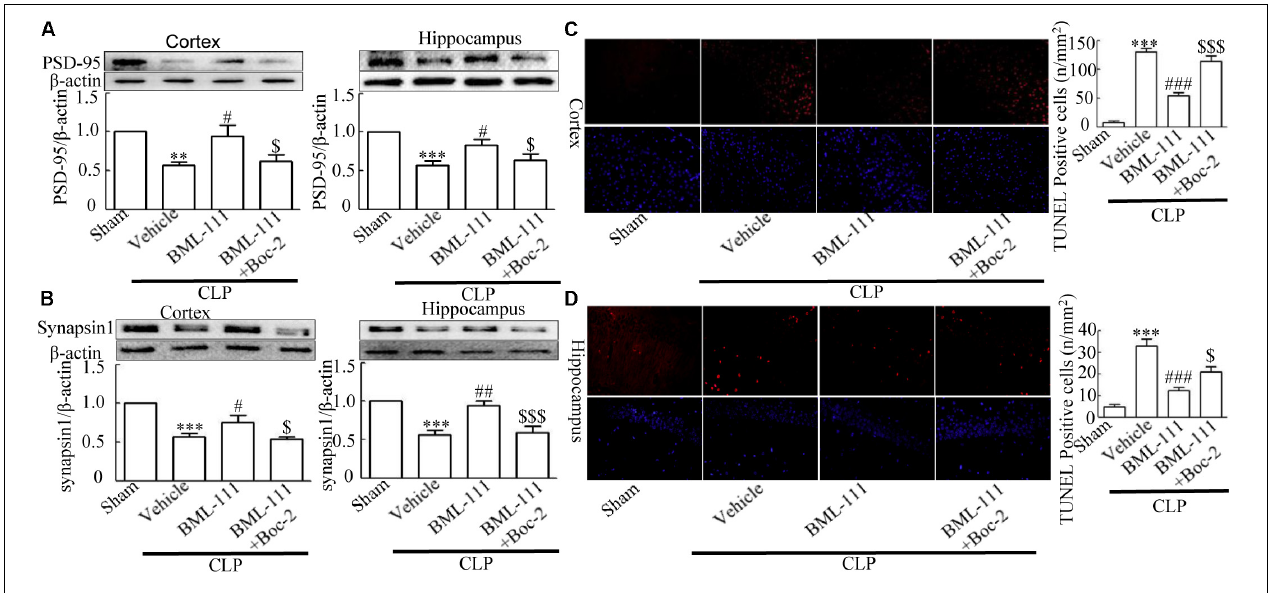
FIGURE 4 | BML-111 treatment reduces the decreases in PSD95, Synapsin1 and TUNEL-positive cells. PSD95 and Synapsin1 (A,B) in the cortex and hippocampus were significantly reduced in CLP mice compared with the sham group. BML-111 treatment increased the expression of PSD95 and Synapsin1 in CLP mice, and Boc-2 decreased the effects of BML-111. (C,D) The number of TUNEL-positive cells was significantly increased in CLP mice compared with the sham group. BML-111 treatment reversed this variation in CLP mice, and Boc-2 reduced these effects. Scale bars indicate 20 mm. Data were shown as the means ± SEM ( n = 6 surviving mice in A cortex, n = 5 surviving mice in A hippocampus, n = 6 surviving mice in B cortex, n = 4 surviving mice in B hippocampus, n = 3 surviving mice per group in C,D ). ∗∗ P < 0.01, ∗∗∗ P < 0.001 represent CLP + Vehicle vs. Sham, # P < 0.05, ## P < 0.01, ### P < 0.001 represents